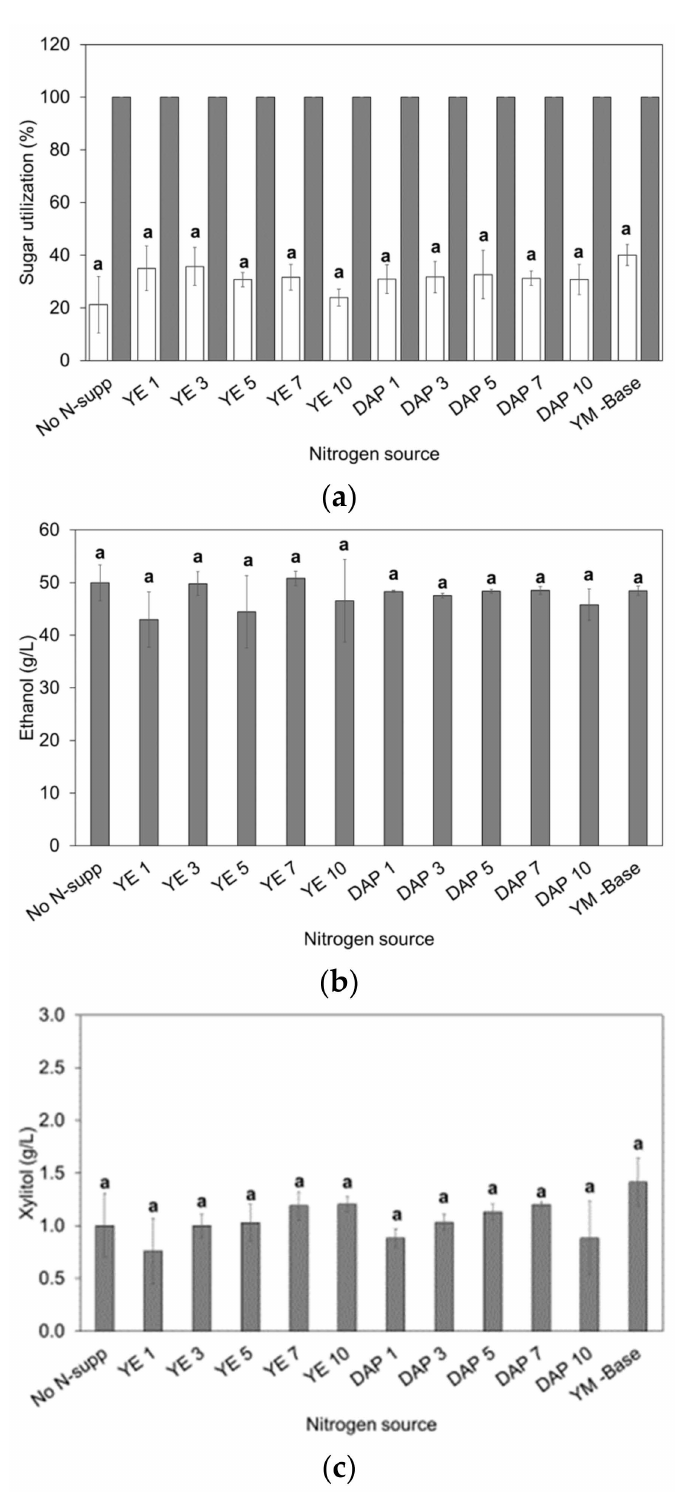
Figure 1. Comparisons of ( a ) sugar utilization (dark bars—glucose, white bars—xylose), ( b ) ethanol, and ( c ) xylitol from ethanol fermentation by S. cerevisiae using sugarcane bagasse hydrolysate, supplemented with yeast extract (YE) or diammonium phosphate (DAP), cultivated at 30 ◦ C, 100 rpm for 36 h. Numbers following YE and DAP are concentrations of the respective nitrogen sources in g/L. The same letters above the bars indicated non-significant difference in mean